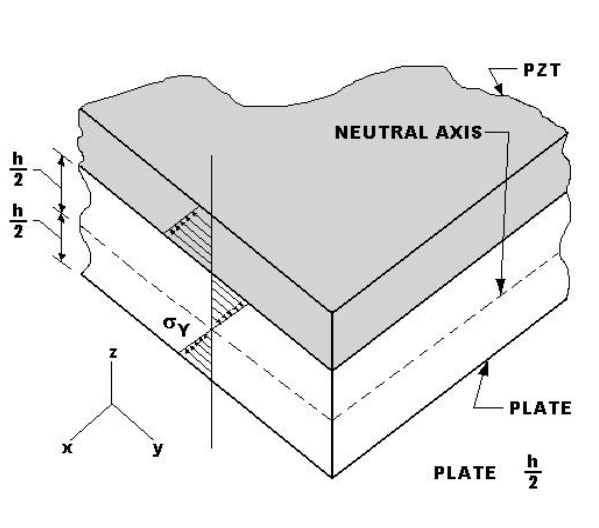
Fig. 1. Lateral sides of an element of the PZT with the plate